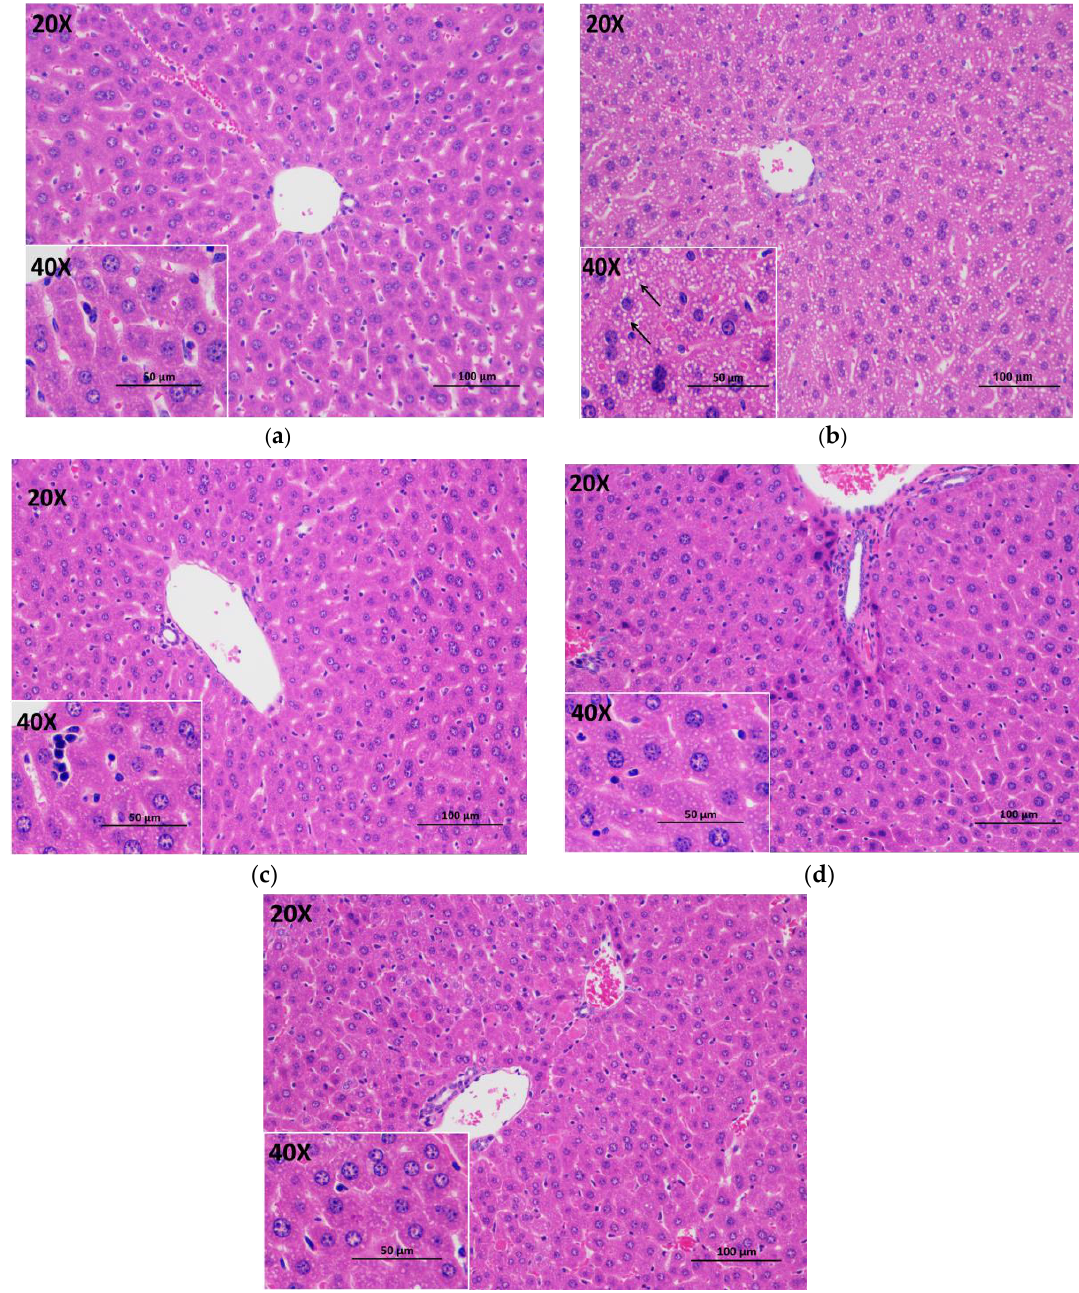
Figure 5. The photomicrographs of liver sections stained by hematoxylin–eosin: ( a ) control group; ( b ) model group; ( c ) Black Fu Brick Tea; ( d ) Wuyi Narcissus Tea; ( e ) Pu-erh Tea. Arrows indicate lipid drops.